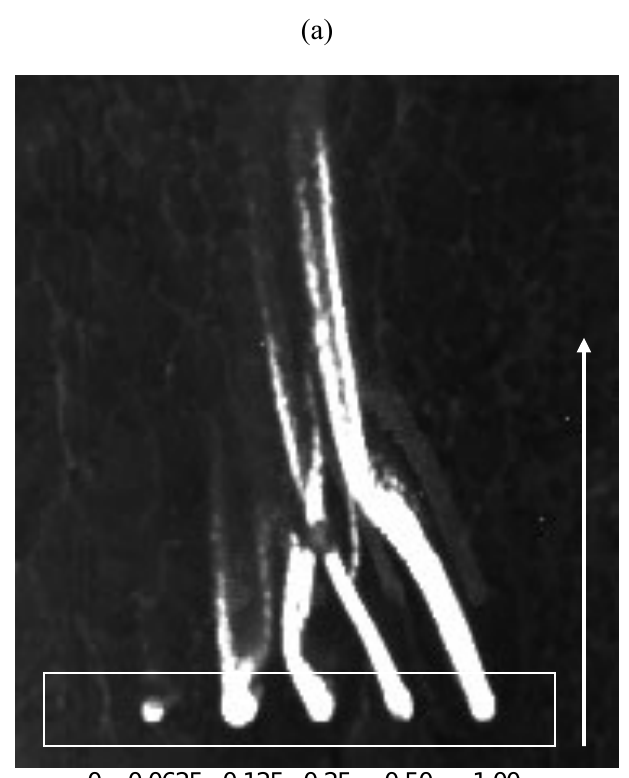
Figure 1. (a) Spread of differing concentrations of biotinylated anti- E. coli O157:H7 capture antibodies (white box indicates site of contact printing by microarray printer), in 135 µm diameter spots (1.1 nL) of 60% PBS:40% glycerol solution (v/v), across streptavidin-coated microscope slides following shearing force (100 μ L PBS plus 1% BSA solution [wt/v] applied to one end of a microarray coverslip for blocking purposes; white arrow indicates directionality of flow). After 1 h incubation, the slide was used to capture and detect 1.6 x 10 9 E. coli O157:H7 cells using a sandwich immunoassay. (b) Correlation between fluorescence intensity (shown in arbitrary fluorescence units, or AFU) and relative spot diameter (measured with a ruler and shown in arbitrary units, or AU), following completion of sandwich immunoassay, at the site of contact printing in Figure